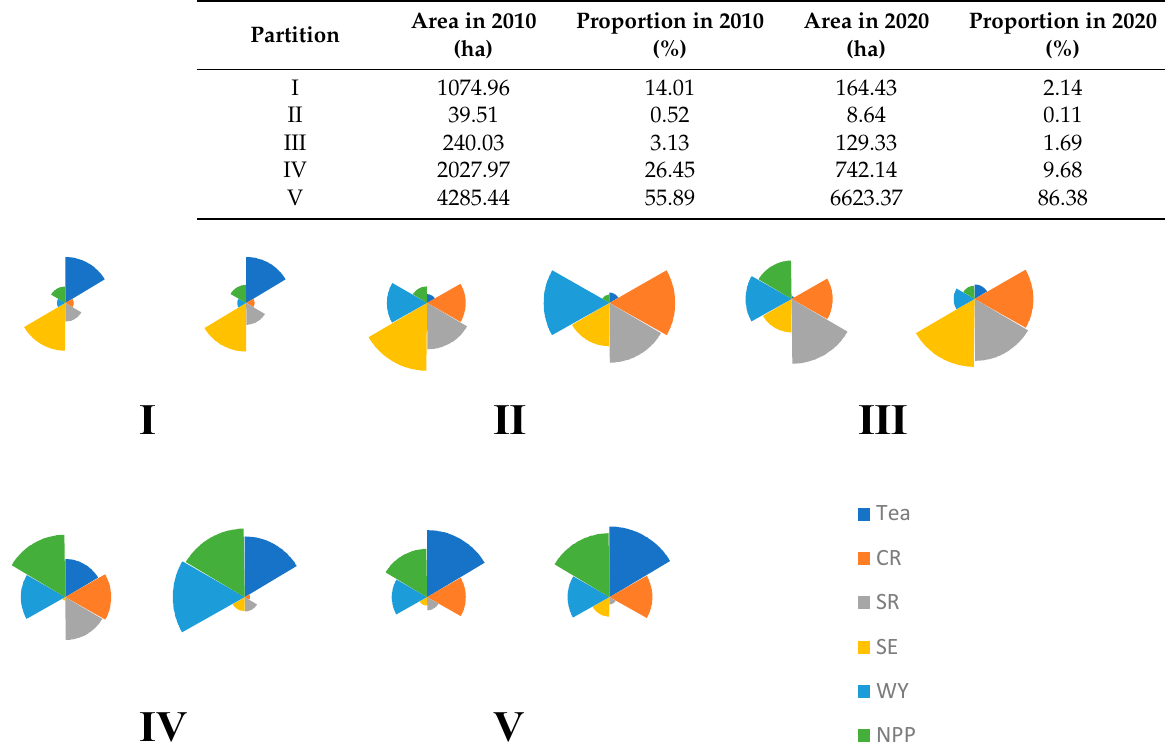
Figure 8. Fuzhou tea garden regional ecosystem service cluster (left: 2010; right: 2020). Tea: tea production; WY: water yield; CR: climate regulation; SR: soil retention; SE: soil erosion; and CE: carbon emissions. Table 6. Statistics of the tea garden ES partitions in Fuzhou.